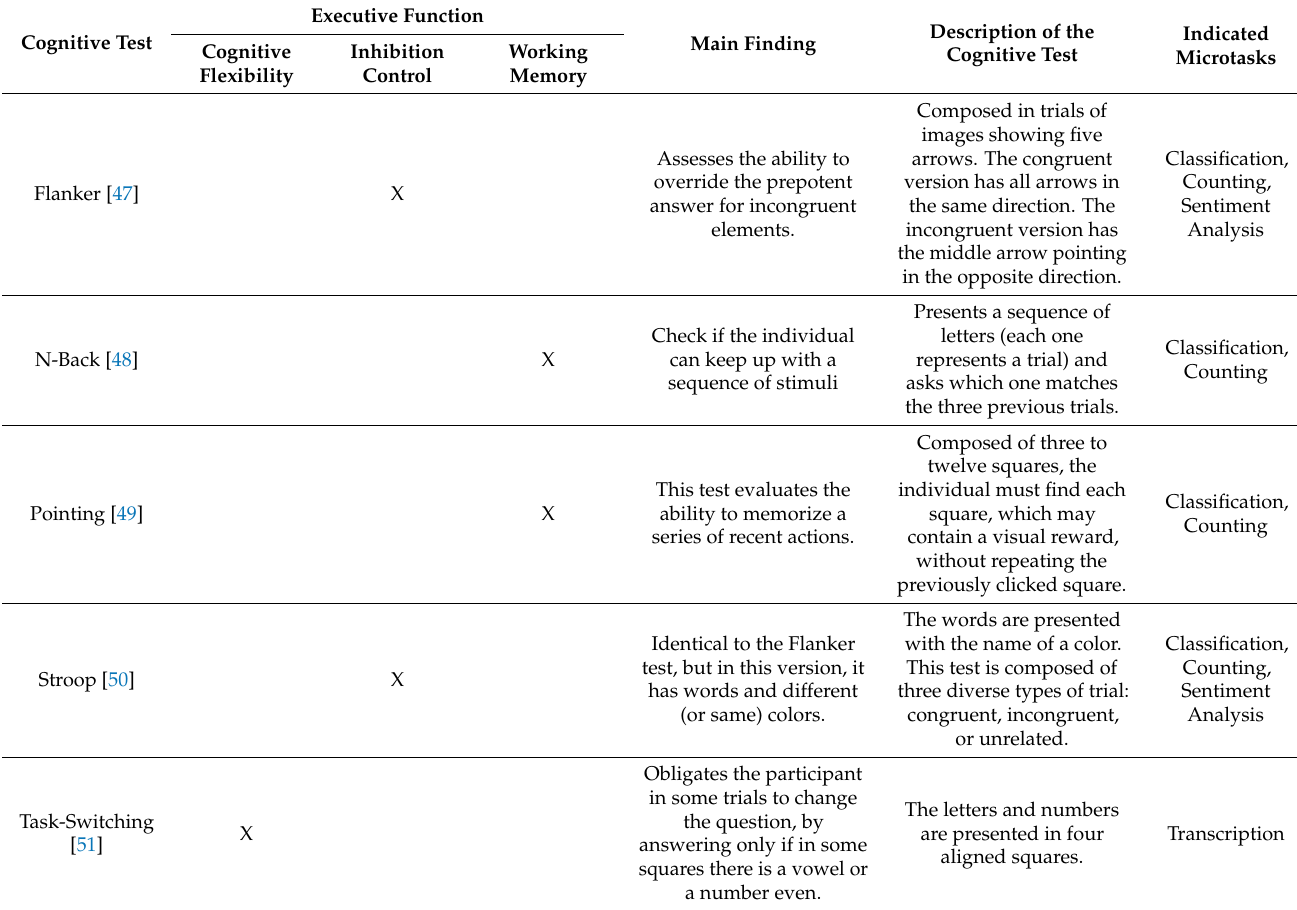
Table 1. Summary of the microtasks applied in this case study, consisting of cognitive tests and their positive relationship with the microtask (according to Hettiachchi and colleagues